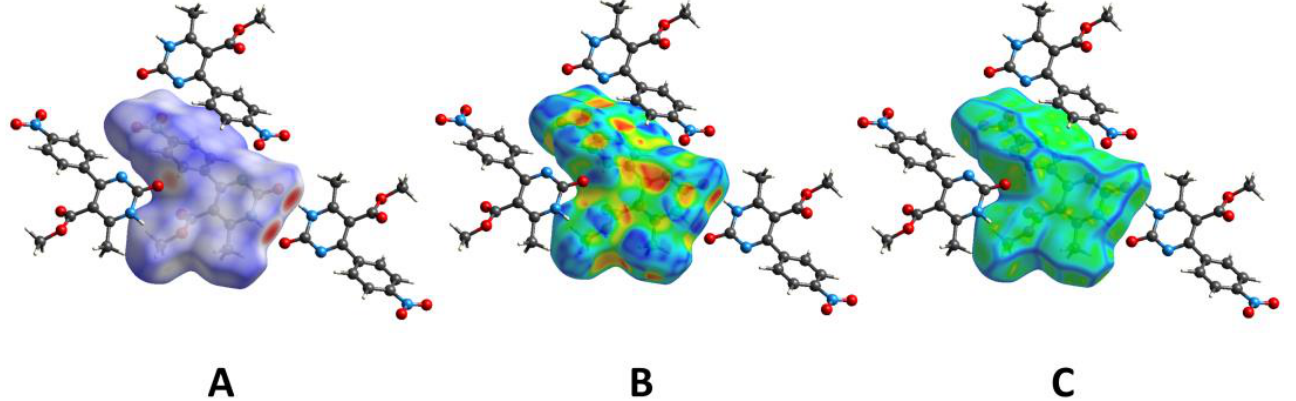
Figure 6. ( A ) HS mapped over d norm with a fixed color scale in the range − 0.6640 au (red)–1.1565 au (blue), based on the length of the intermolecular contacts with respect to the sum of the van der Waals radii (red: shorter; blue: longer; white: same). ( B ) HS mapped over the shape-index (color scale: − 0.9976 au–0.9959 au). Blue areas represent bumps and red regions indicate hollows. ( C ) HS mapped over the curvedness (color scale: −3.6750 au–0.2678 au). Green represents flat regions and blue indicates edges.